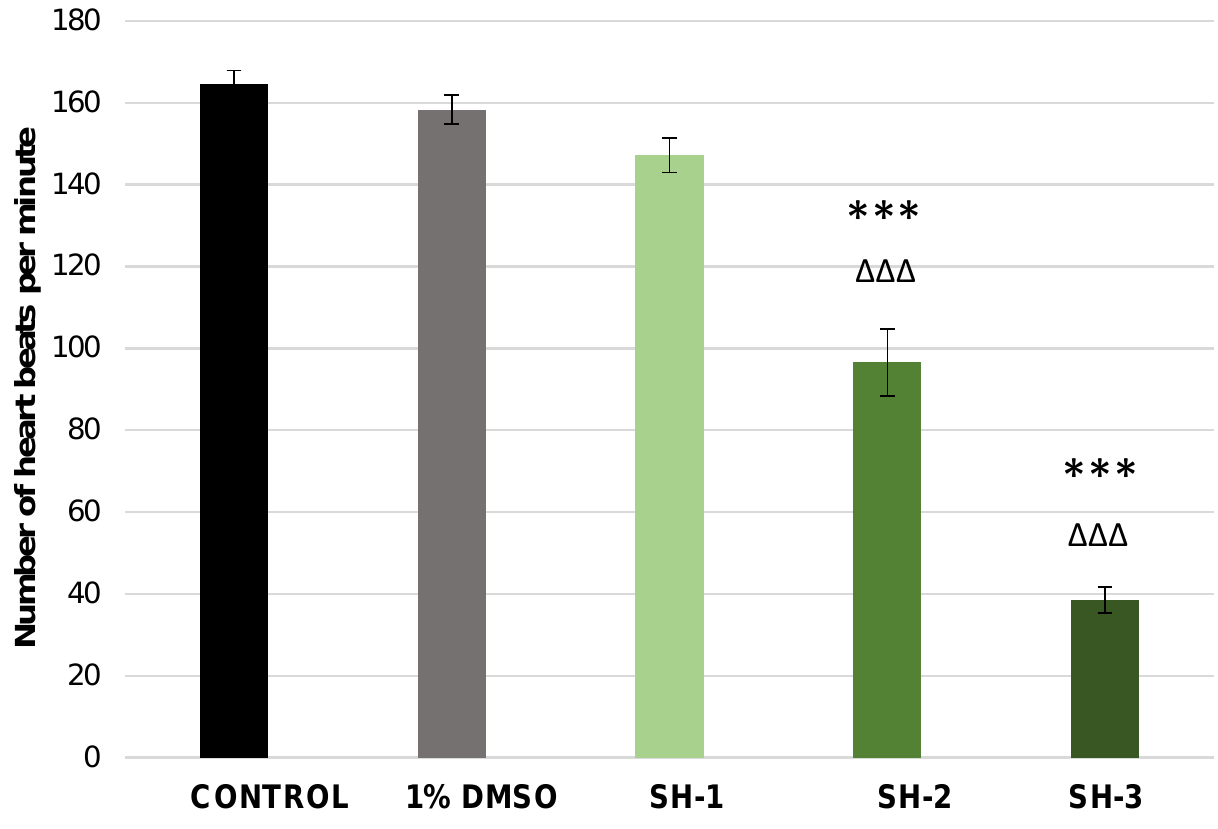
Figure 2. The number of heart beats per minute of zebrafish larvae (wild-type AB strain) after 96-h exposure to control solutions and N -[(3-chloro-4-methoxyphenyl)methylidene]-4-methylbenzenesulphonohydrazide ( SH ) at the following concentrations: 1 —16.94 mg/L (50 µ M), 2 —33.88 mg/L (100 µ M), 3 —84.70 mg/L (250 µ M) (*** p < 0.001 vs. negative control; ∆∆∆ p < 0.001 vs. 1% DMSO).